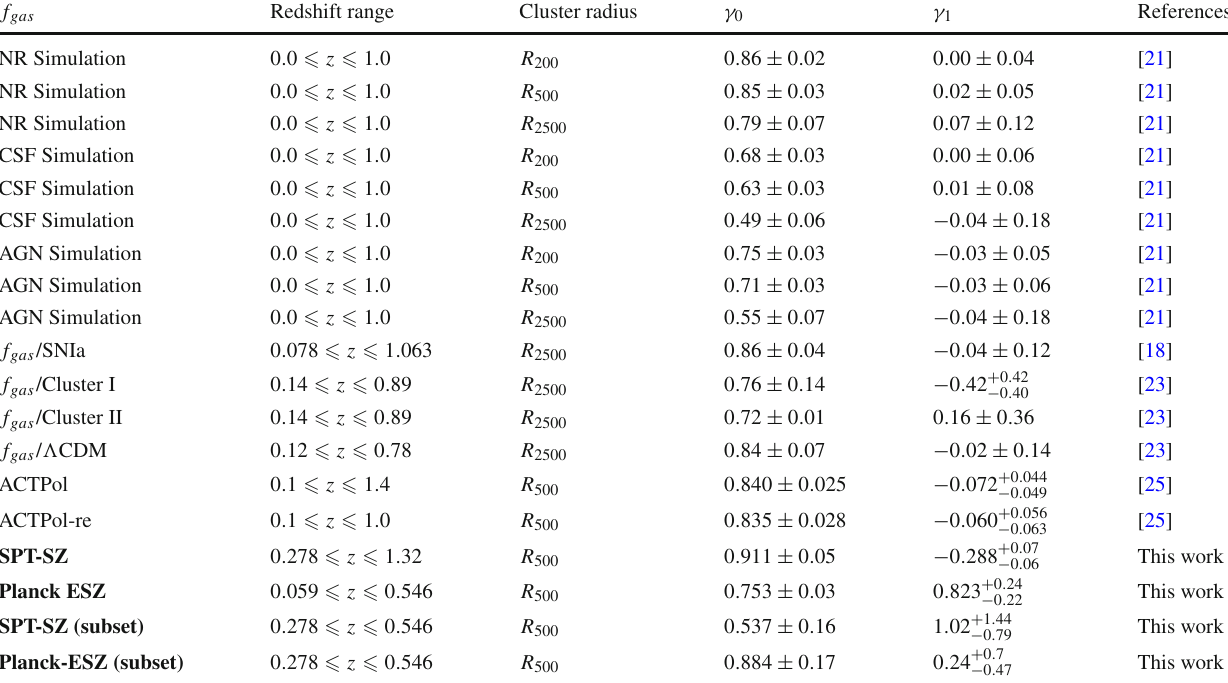
Table 2 Constraints on parameters γ 0 and γ 1 (cf. Eq. (1)) from different estimates in literature (including this work). The last two rows show the gas depletion factors for a subset of SPT-SZ and Planck ESZ clusters within the same redshift range